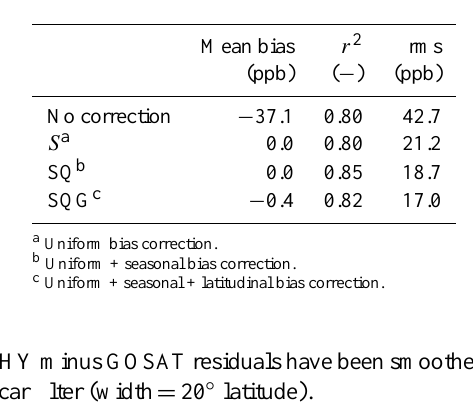
Table 2. Statistics of X CH 4 residuals between TCCON and bias- corrected SCIAMACHY retrievals.